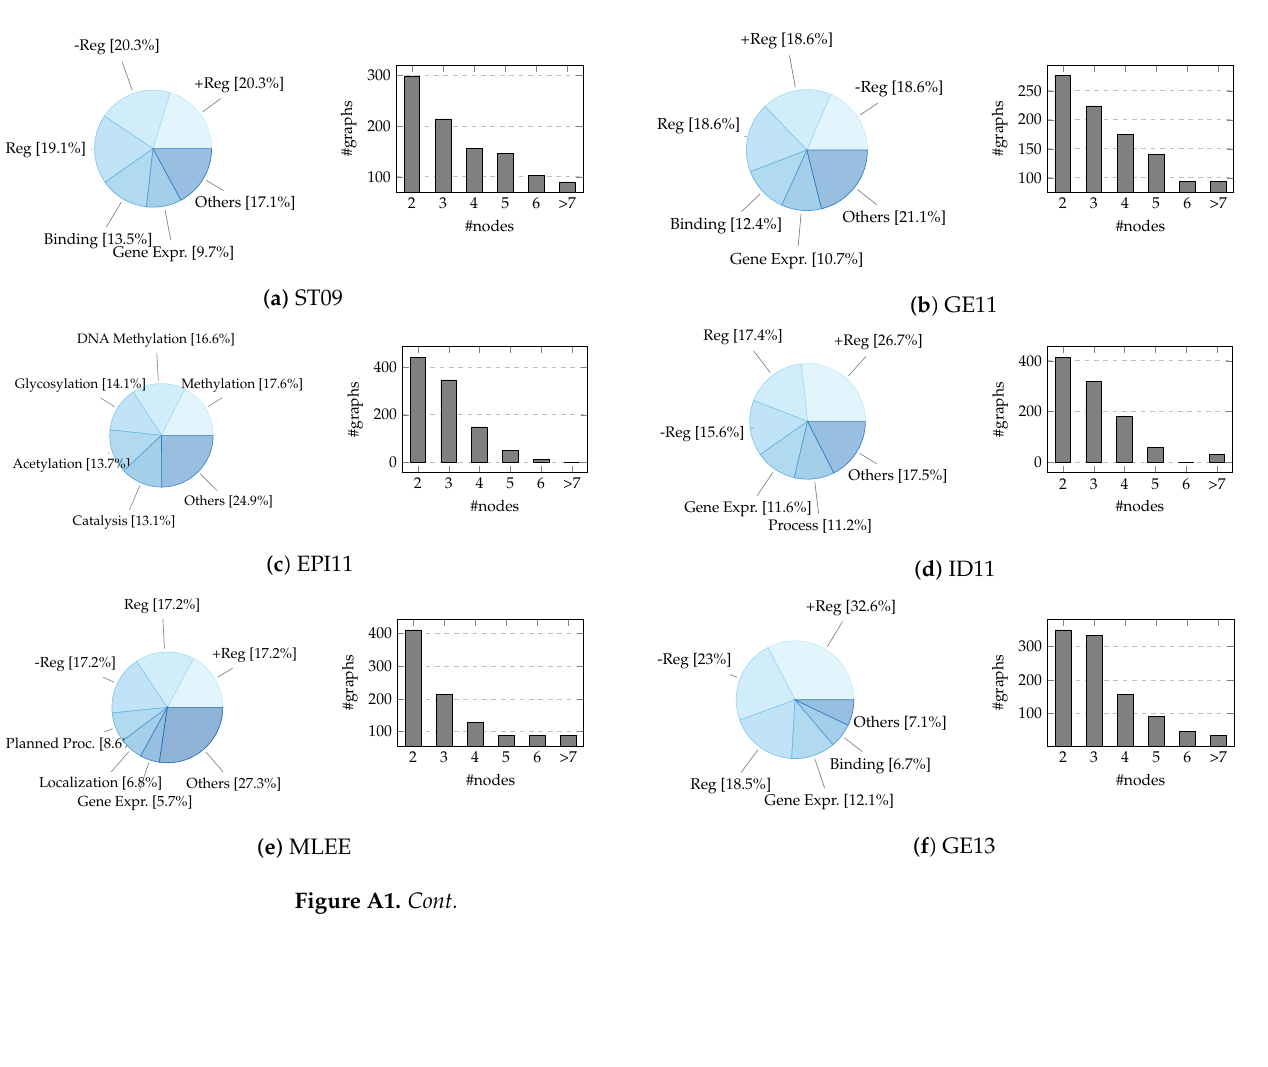
(j) ALL Figure 1. Distribution of event types (root ones, in case of nesting) and graph sizes within sampled datasets.